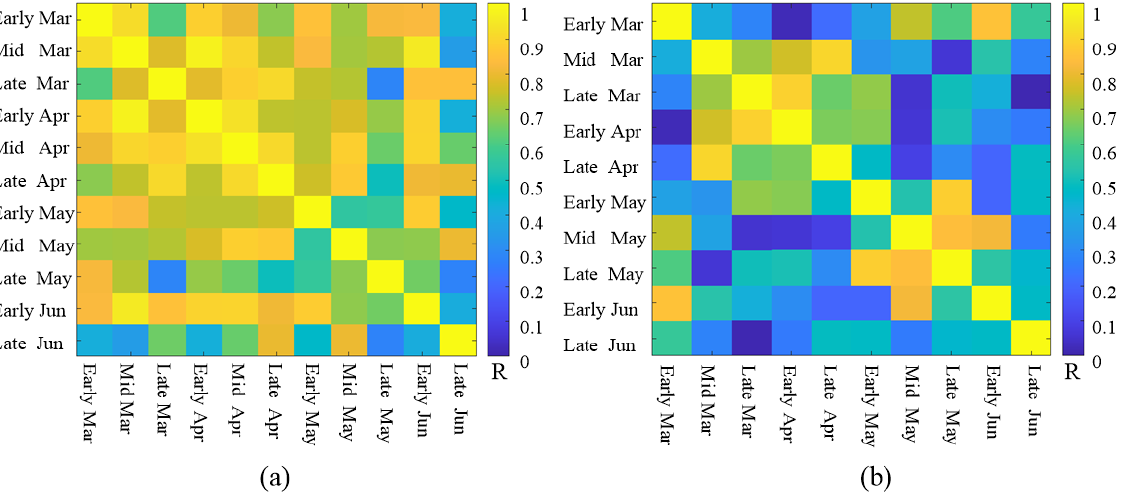
Figure 6. Matrix of cross-correlation analysis for ten-day average temperature ( a ); and relative humidity ( b ).